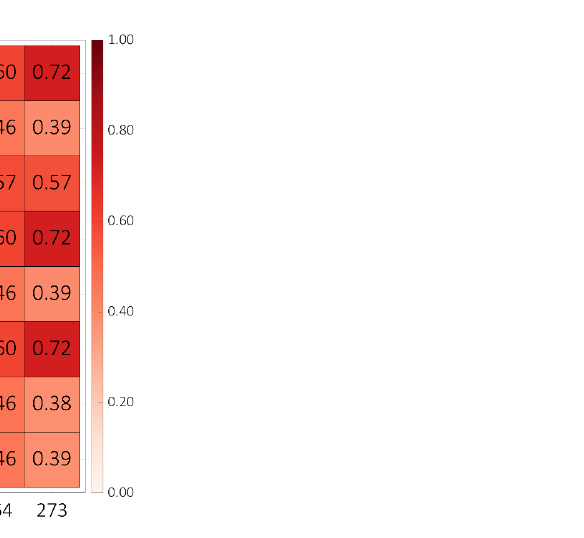
Figure 5. The R 2 values between the multispectral-based VIs and maize grain yields using data of 20 plots at each growth stage using the linear regression method. The x-axis represents the DOY and the y-axis represents the different indices.